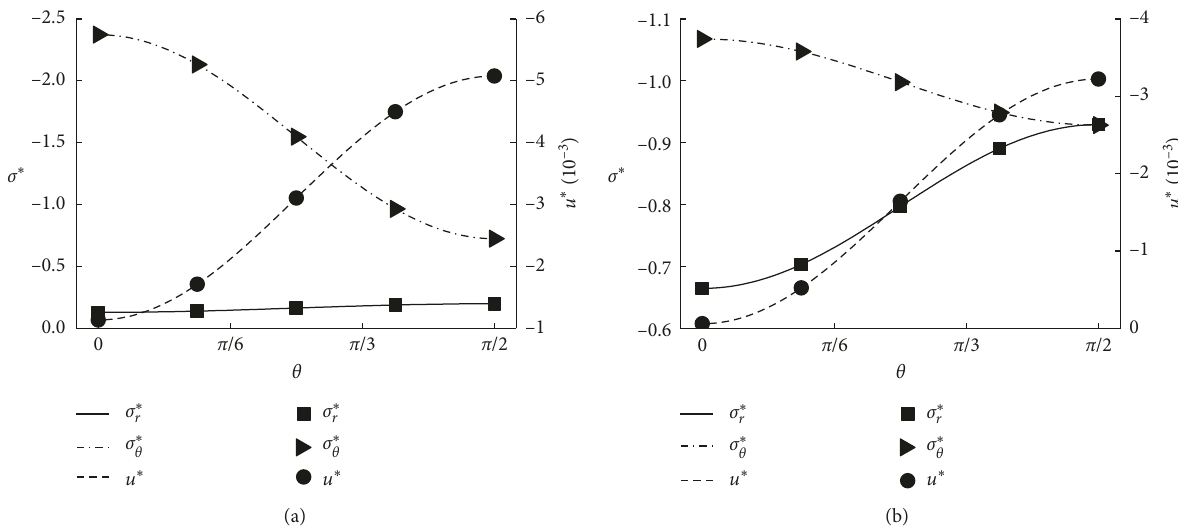
Figure 5: Variation of σ ∗